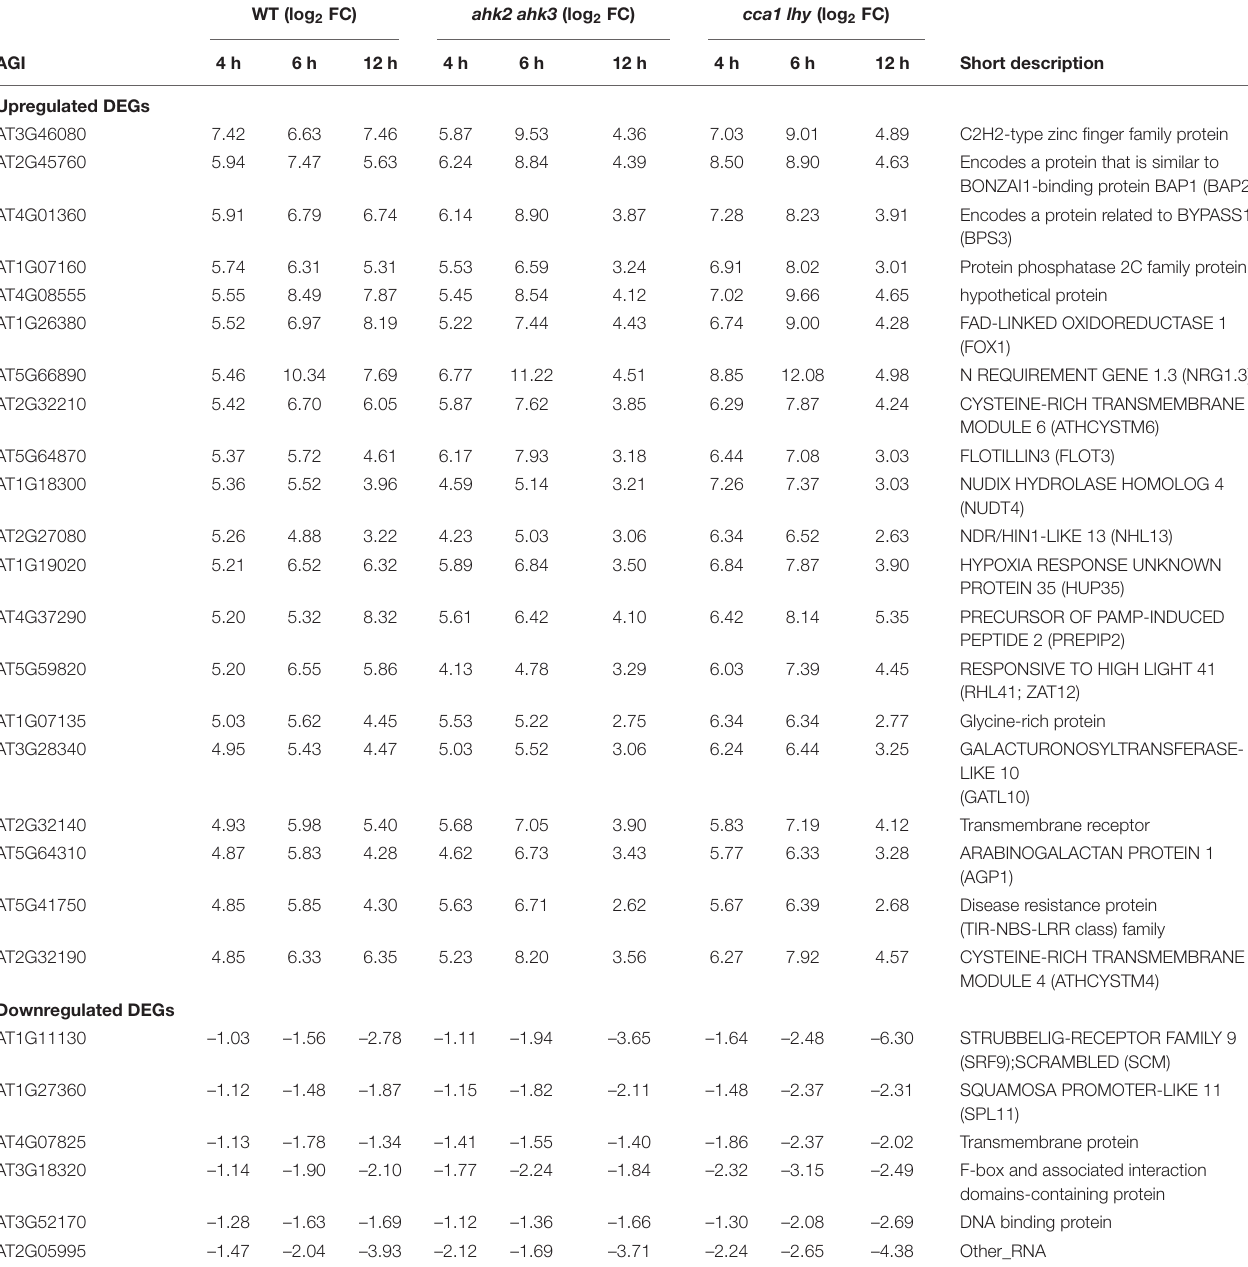
TABLE 1 | Selection of the core-set of photoperiod stress-responsive